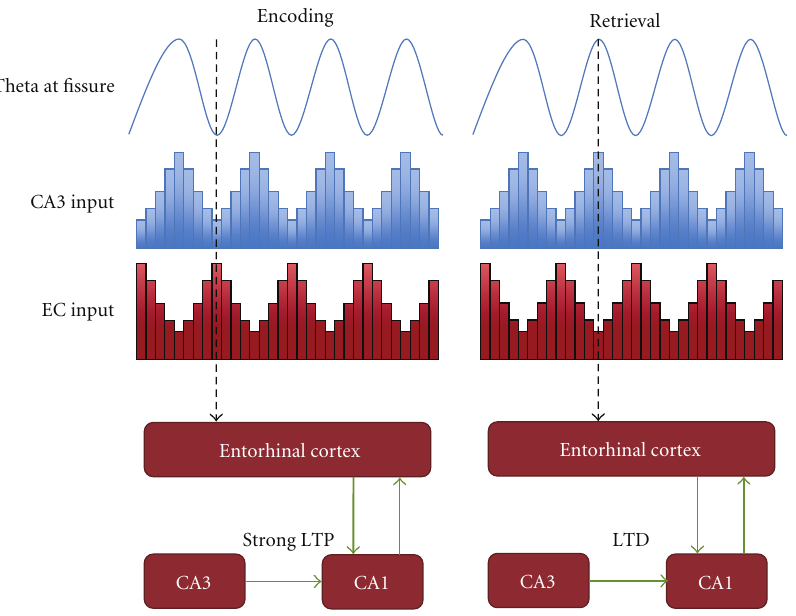
Figure 2: Schematic illustration of the Hasselmo et al. model. Redrawn from